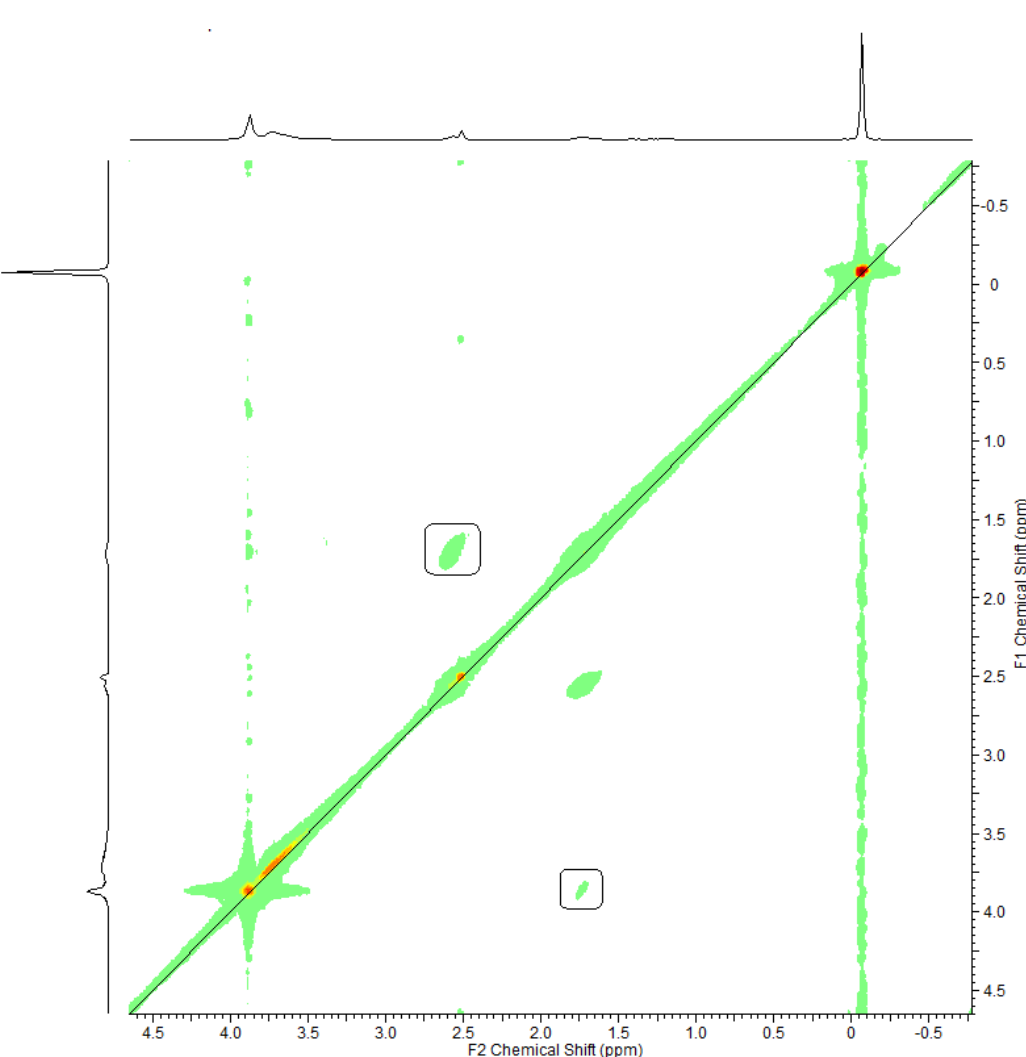
Figure 4. 1 H– 1 H 2D COSY spectrum of SBL. The coupled protons are shown in the squares.